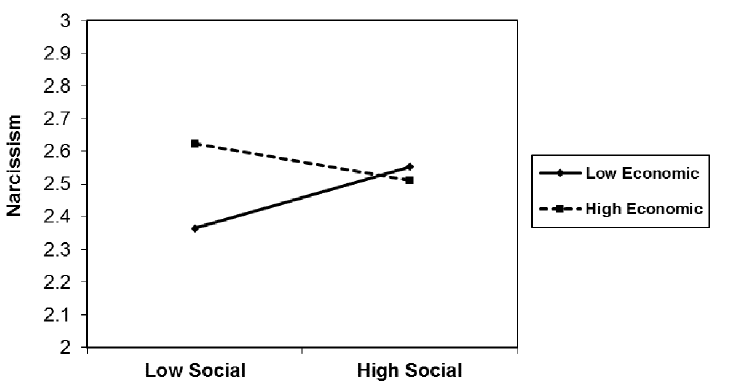
Figure 6. The Study 2 interaction between social and economic political ideology (measured via multi-item measures) in relation to